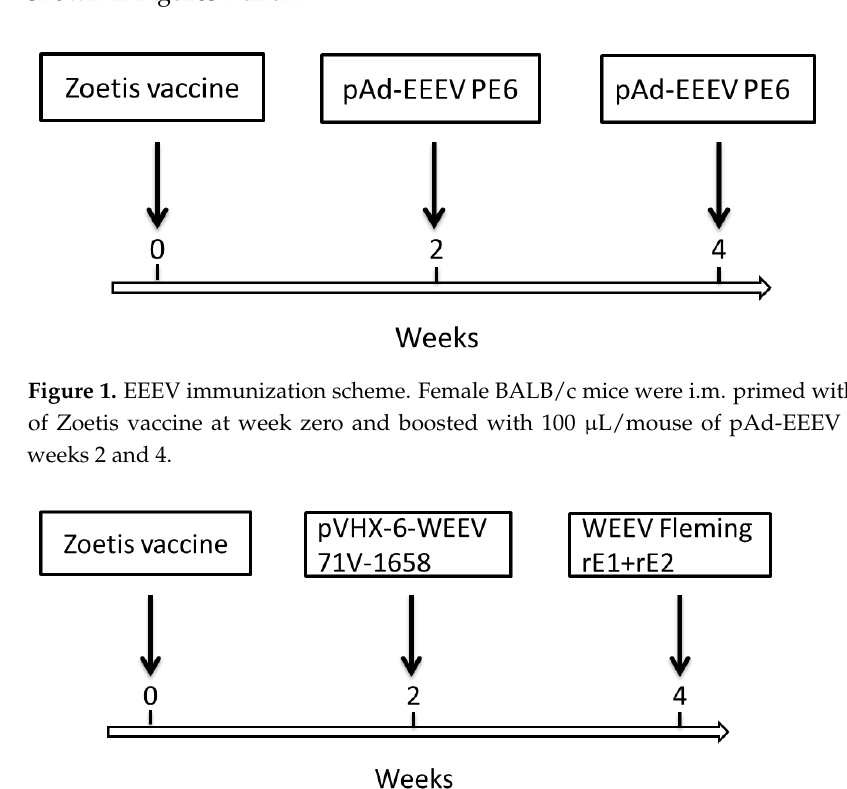
Figure 2. WEEV immunization scheme. Female BALB/c mice were i.m. primed with 100 µL/mouse of Zoetis vaccine at week zero and boosted with 100 µL/mouse of pVHX-6-WEEV 71V-1658 (100 µg) at week 2 and 100 µL/mouse of rE2 (100 µg) and rE1 (100 µg) of WEEV Fleming emulsified in 100 µL of TiterMax Gold adjuvant at week 4.